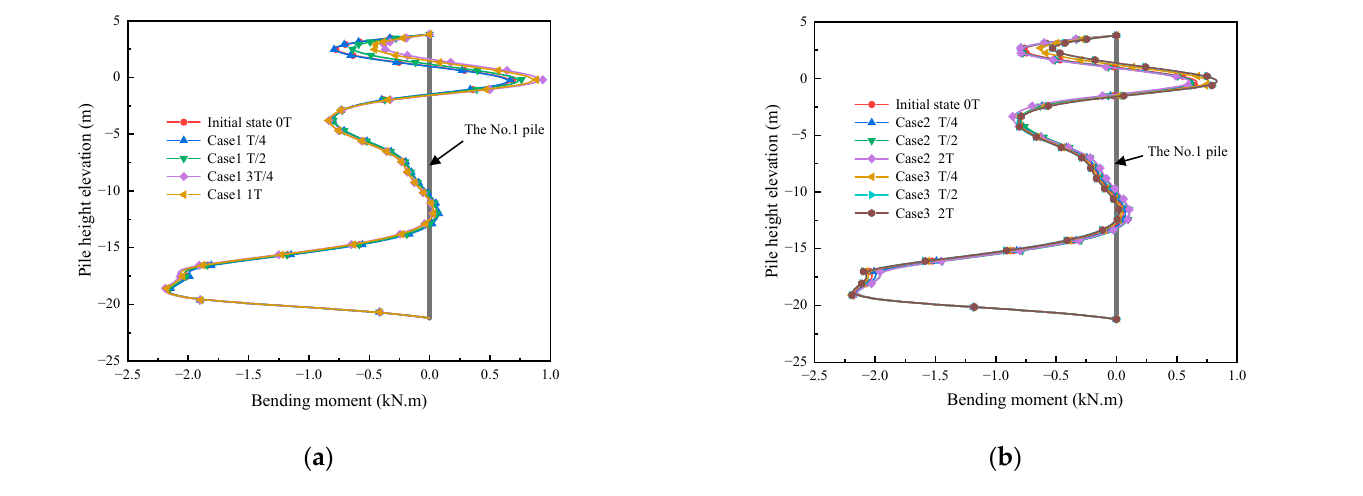
Figure 11. Bending moment distribution of pile No. 1 under three cases: ( a ) Bending moment distribution of the No. 1 pile body under tidal action. ( b ) Bending moment distribution of the No. 1 pile body when the water level rises and falls suddenly.